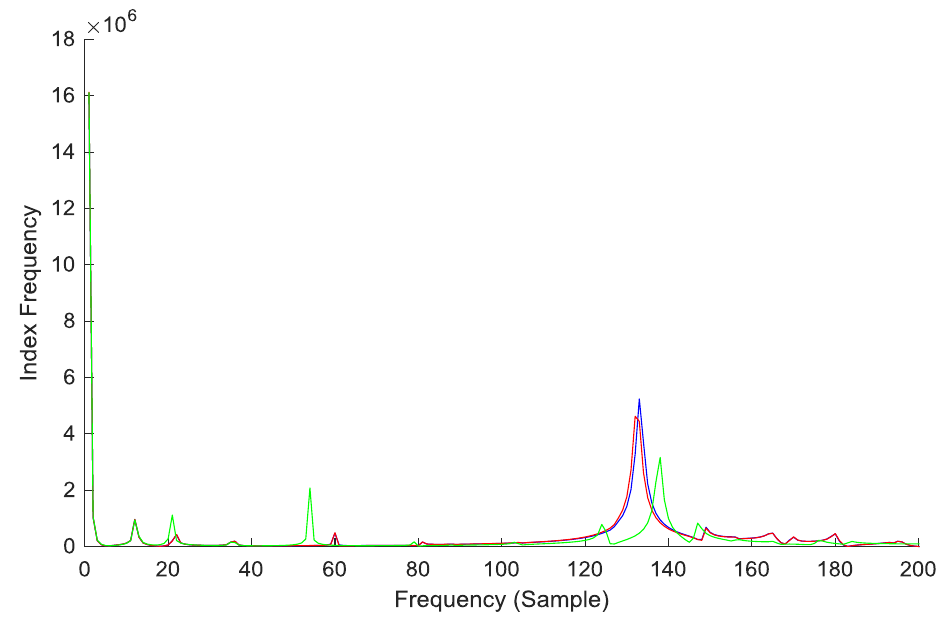
Figure 14. Simultaneous representation of real transient frequency component and the theoretically calculated transient frequency component based on the proposed method (Figures 11–13).